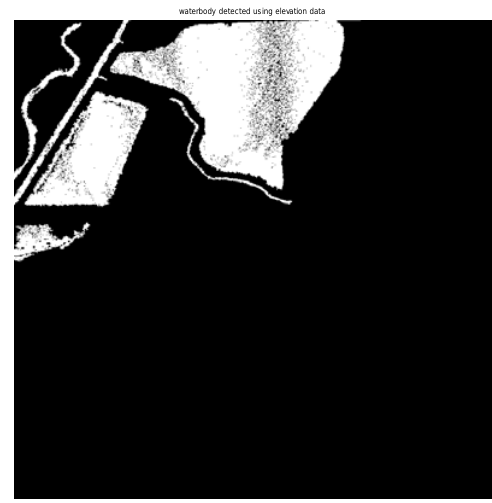
Figure 7. Water body detected using elevation data 2.5 Detecting water bodies using intensity data